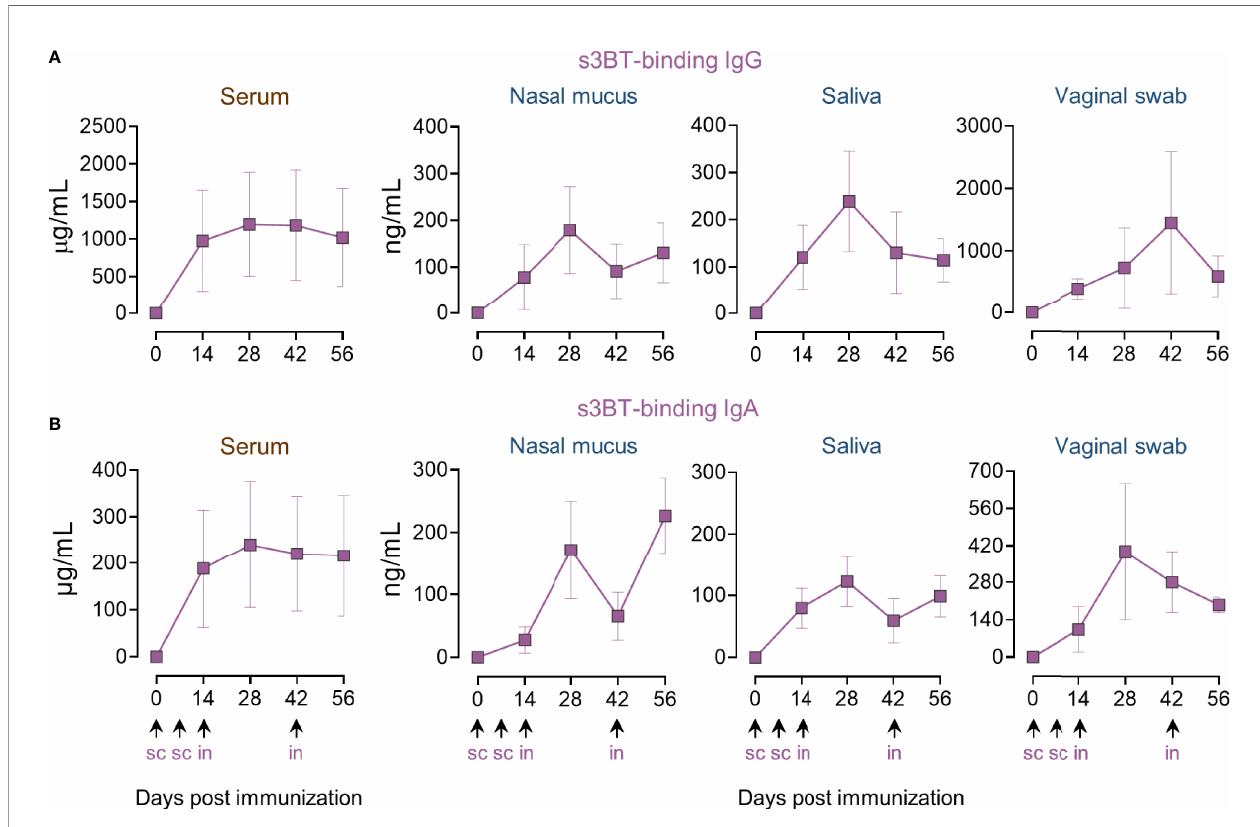
FIGURE 3 | Combined s.c.-i.n. immunization with s3BT results in the production of antigen-binding IgG and IgA in serum and mucosal fl uids. Animals were inoculated with 100 µg of puri fi ed s3BT protein mixed with IFA 1:1 (v/v) in the fi rst two s.c. doses, and 200 µg of s3BT without adjuvant for intranasal immunizations. Dynamics of serum and mucosal anti-s3BT IgG (A) and IgA (B) , assayed by quantitative ELISA using s3BT. The scales are different in the vaginal swab graphs. Error bars represent